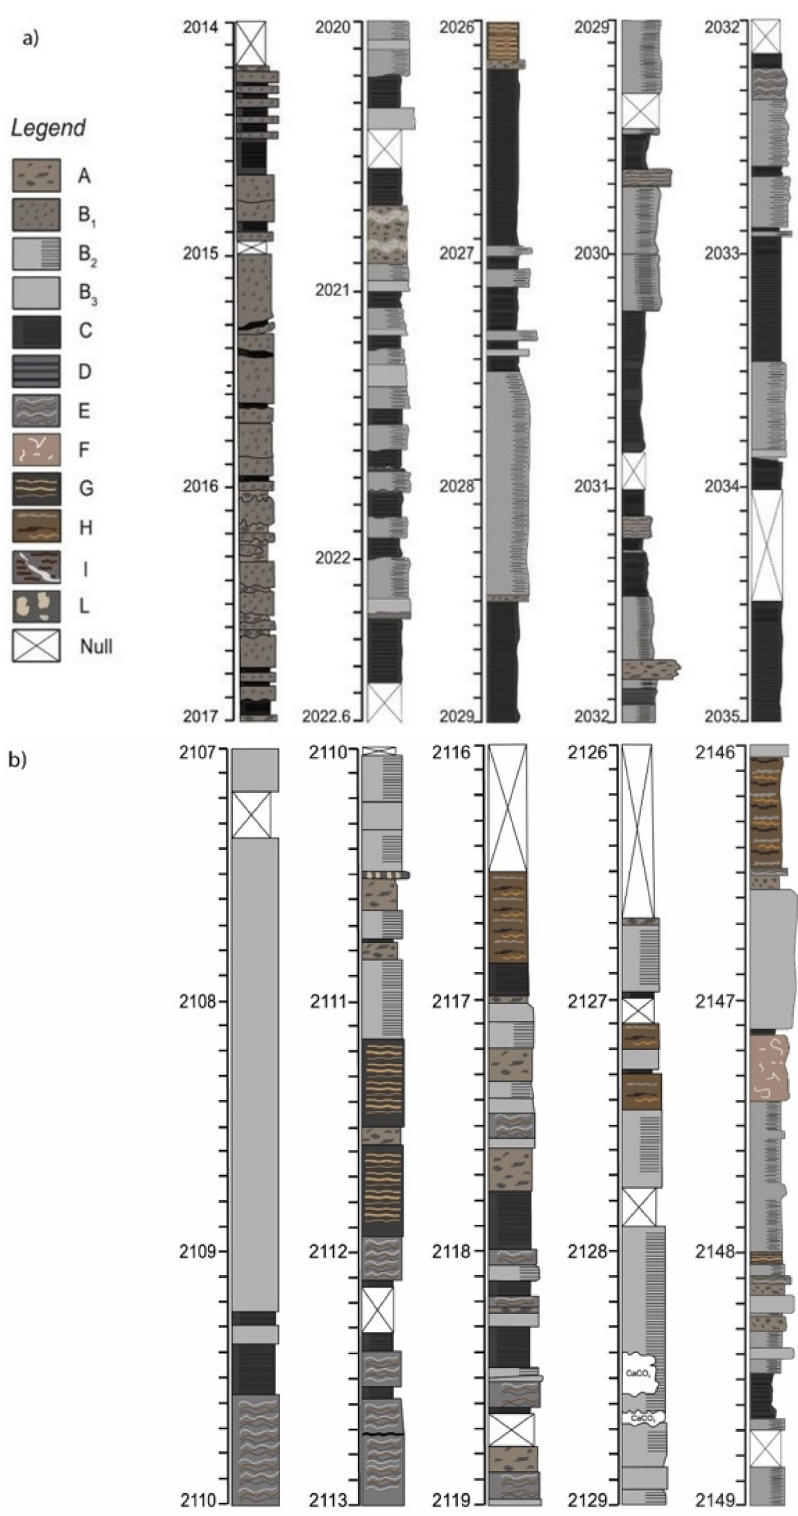
Figure 2. Schematic drawing of the convention used for the measurement of azimuths and dip angles of the different structures present in the cores and techniques used for the measurement of the structural planes in the three dimensions in the interim reference system in the archive half- cores. On the E-W plane (of the interim reference system), the apparent immersions (0–180°) of the planes of the various structural elements were measured, where 0° referred to a horizontal line, perpendicular to the vertical reference line, and 90° to a vertical line, parallel to the vertical reference line. A second apparent dip angle (90–270°) was measured on the half semicircle of the archive half- core, placed on a horizontal plane perpendicular to both the interim E-W and N-S planes, where 90° Fracture density per linear meter and cumulative length of the fractures per meter, referred to a horizontal line, perpendicular to the N-S plane, and 180° to a vertical line, perpendic- measured in this work were correlated with well logs. ular to the E-W plane.